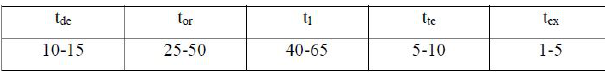
Table1 Percentage of the components of the